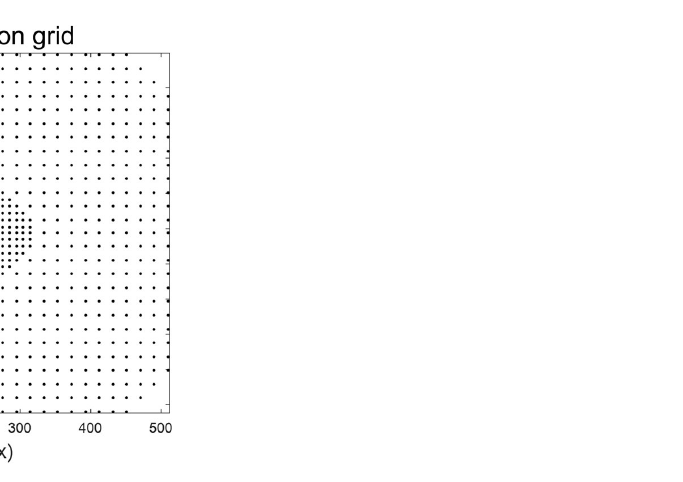
Figure 9. ( a ) SPST i,j with i = 32 and j = 96 to 256. When the field is varied along the horizontal direc ‐ tion, ghosts moves in that direction too, thus their distance from the center all evolve with the same ratio. ( b ) SPST interpolated with one neighbor, with missing signal on the edges. ( c ) SPST interpo ‐ lated with up to 4 neighbors to fill, with no missing signal on the edges.